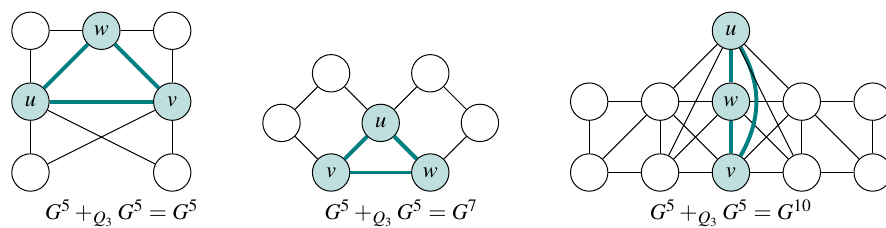
Figure 7. Glued graphs G 5 via Q 3 with vertices u , v , w .